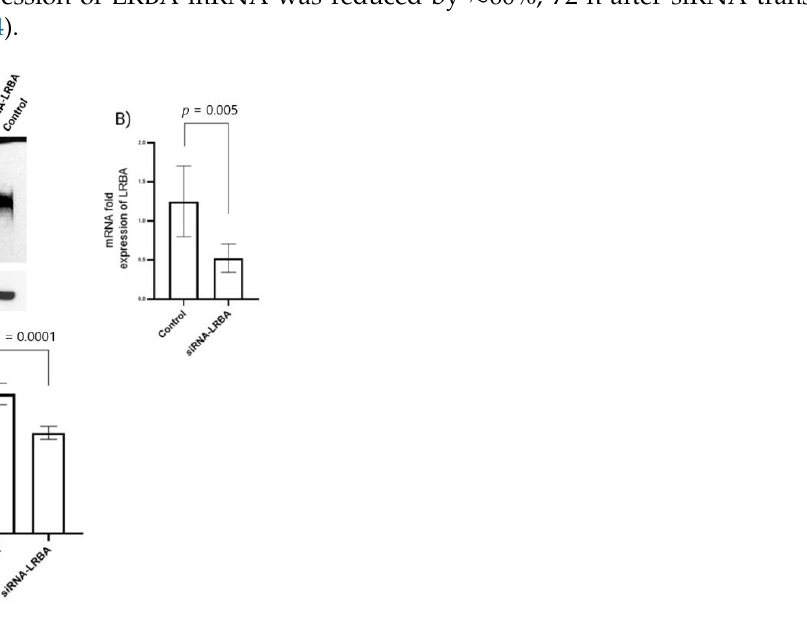
Figure 5. Western blots of insulin from LRBA- knockdown MIN6 pancreatic β -cells. Cells were cul- tured in 6-well plates and were transfected for 72 h with LRBA-targeted siRNA. Error bars represent S.D. (*: p < 0.05, ns: non significant). Paired parametric t test was used. 3.5. Knocking down LRBA in MIN6 β -Cells Reduces Cellular Glucose Metabolism while Not Directly Inducing Cells Death The metabolic activity of the cells was monitored by WST-1 reagent in 96-well plates, 72 h after siRNA transfection. This assay assesses the cells ’ ability to cleave the tetrazolium salt and form a formazan dye by the succinate-tetrazolium reductase system in the respir- atory chain of the mitochondria. Knocking down LRBA in MIN6 yielded a ≈30% reduction in cellular glucose metabolism while no increase in apoptosis was observed when com- pared to the wildtype counterpart (Figure 6).